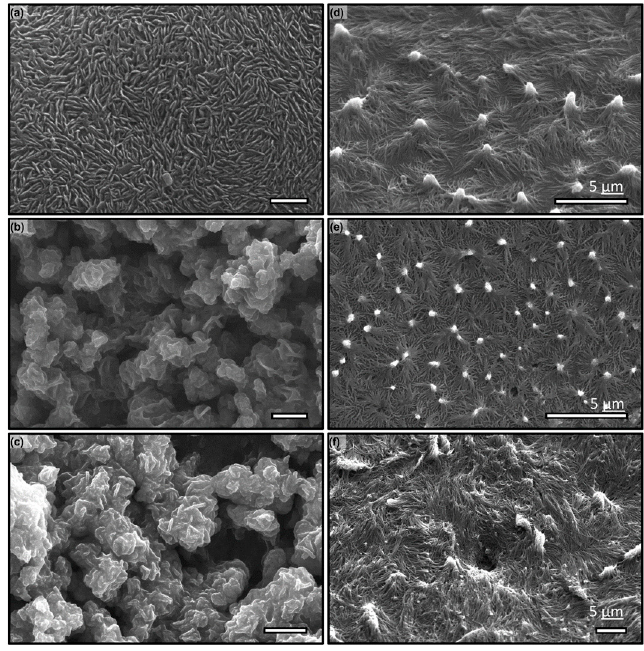
Figure 7. SEM micrographs of ( a – c ) PDMS and ( d – f ) epoxy using AAO templates of 150 nm, aspect ratio (AR) = 12 (a,d), 75 nm, AR = 16 (b,e), and 125 nm, AR = 40 (c,f).